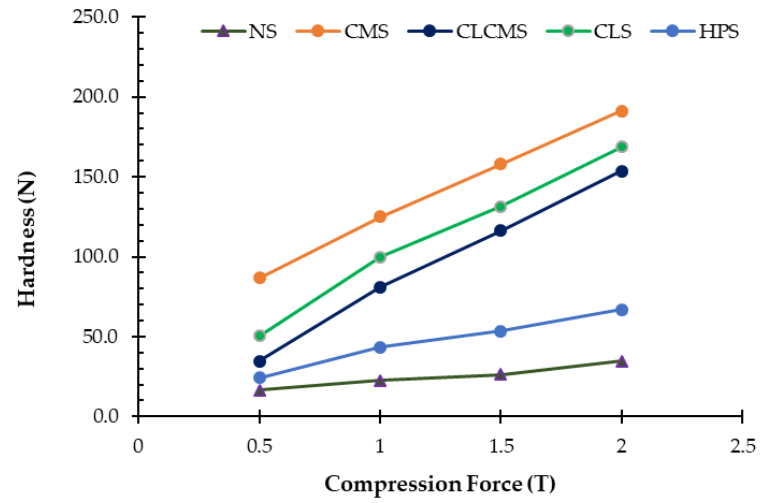
Figure 7. Pressure-hardness Relationship of Native and Modified Starches Prepared from KJ CMU-107 Rice Starch.